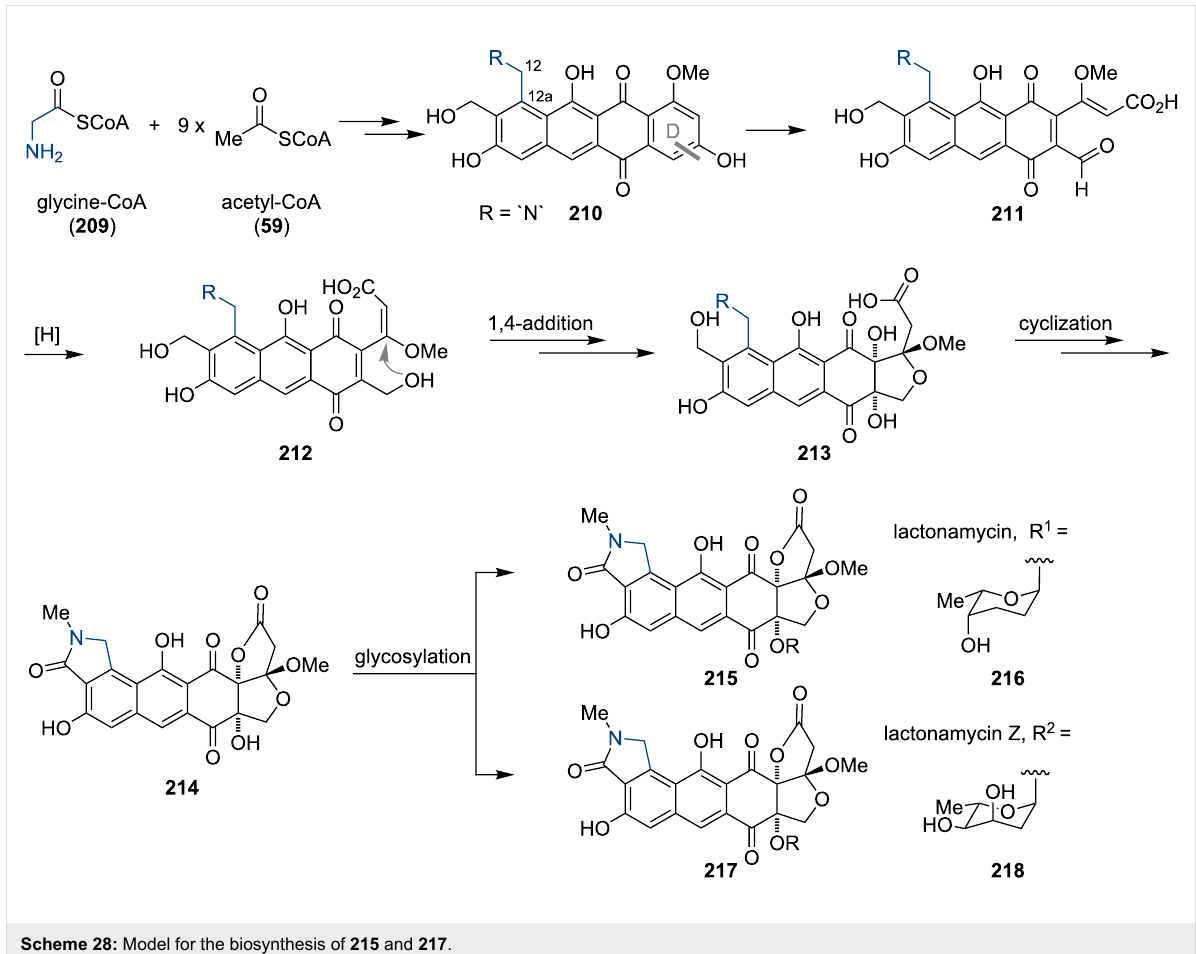
Scheme 28: Model for the biosynthesis of 215 and 217 .